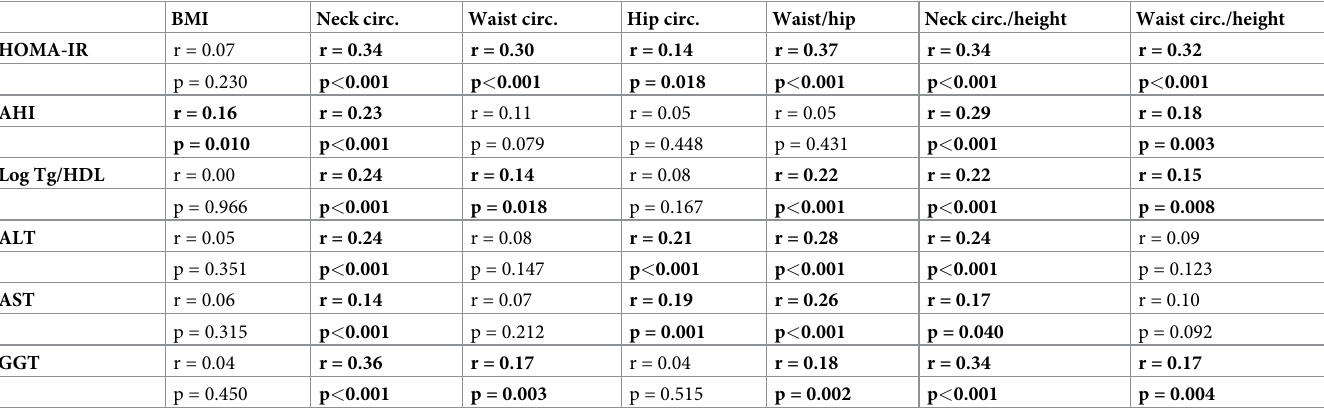
Table 4. Univariate Spearman correlations between anthropometric parameters and cardiometabolic risk markers.